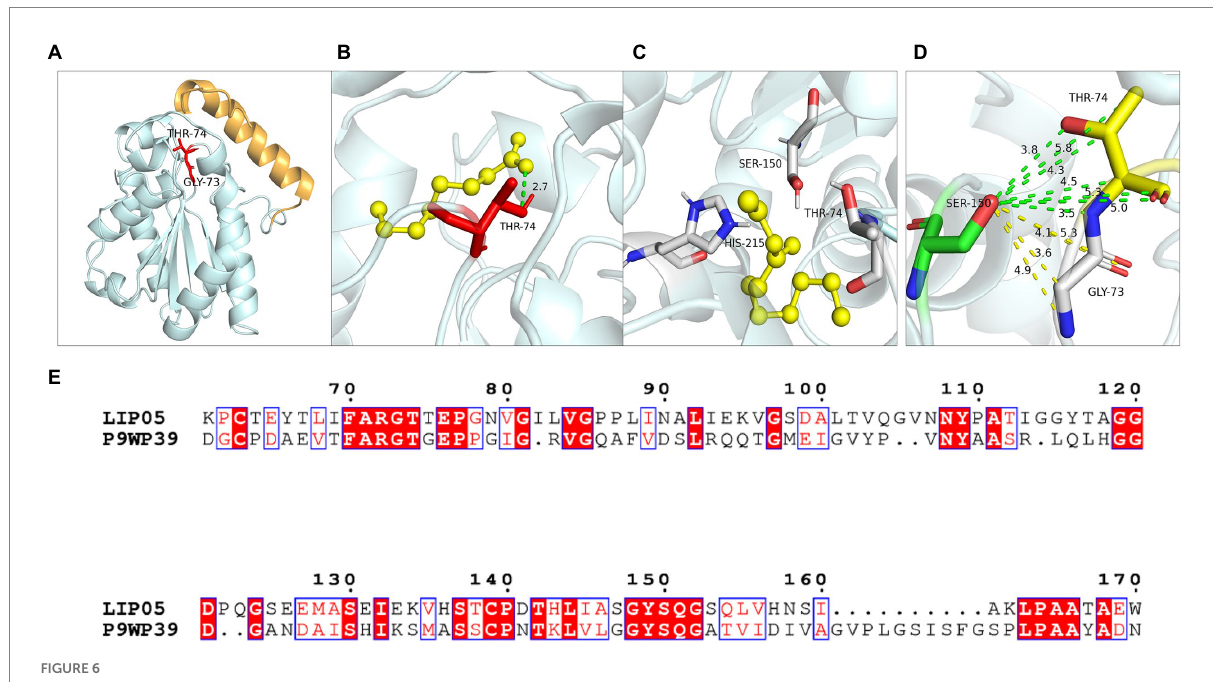
FIGURE 6 Catalytic function analysis of Gly73 and Thr74. (A) Spatial position of Gly73 and Thr74. (B) Molecular docking of LIP05 to octanoic acid at Thr74. (C) Molecular docking of LIP05 to ethyl octanoate at Thr74. (D) Oxygen anion hole at Gly73 and Thr74. (E) Sequence alignment of LIP05 with